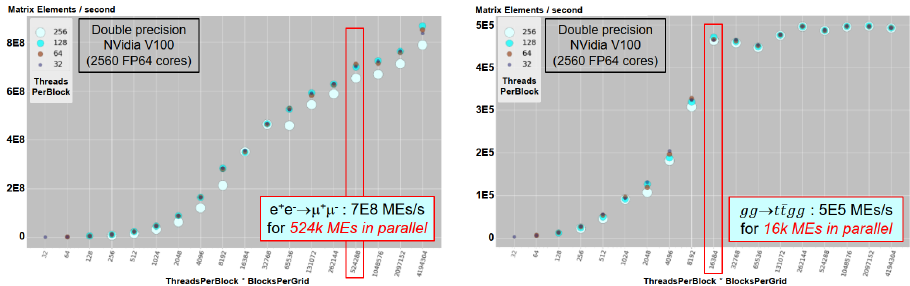
Figure 5. Throughput (MEs per second) of the ME calculation in CUDA, as a function of the number of threads (i.e. the number of events processed in one iteration), using double precision floating point µ + µ − (left) and gg t ¯ t gg (right). Four sets of results are plotted for di ff erent arithmetics, for e + e − → → values of the number of threads per block. Throughputs are computed as the number of MEs divided by the sum of the time to compute them on the GPU device and of the time to copy them to the CPU host. Virtual machine itscrd70 with an Nvidia V100 GPU; details of the software build are given in Tab. 2. For illustrative purposes only, the red boxes in the two plots indicate two examples discussed in the